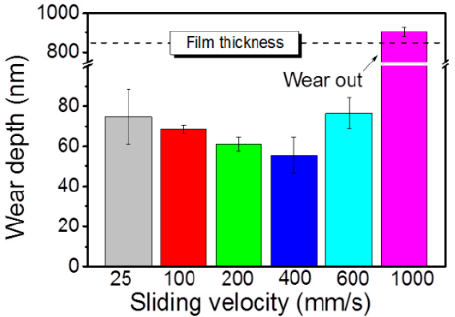
Figure 4. Wear depth of the wear tracks formed on the DLC film under different sliding velocities.